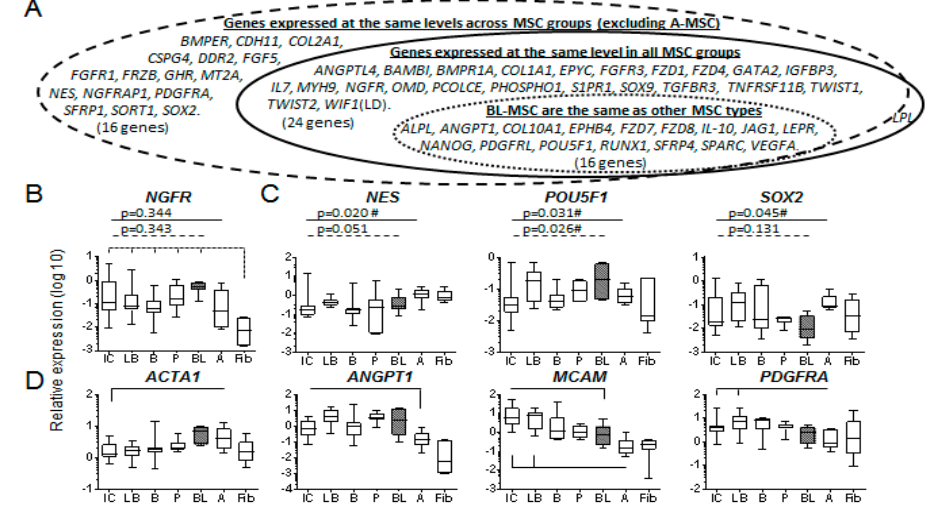
Figure 4. Evidence of molecular similarity of BL-MSCs to other MSC types. ( A ) Representation of gene expression similarity between BL-MSCs and other MSC types. Solid line: same across all MSC groups for 24 genes, dashed line: same for an additional 17 genes (but no longer LPL) when adipose-MSCs were excluded, dotted line: post-hoc multivariate analysis showed that gene expression was the same between blood-MSCs and all other MSC types for a further 14 genes. ( B ) NGFR transcript expression was the same for all MSC types, dashed lines show all MSCs (except adipose-MSCs) distinct from fibroblasts. ( C ) blood-MSCs expressed markers of immaturity at similar levels (Kruskal–Wallis) to other MSC types, no multivariate differences were found between blood and other MSC types. D ) Pericyte-related markers were expressed at similar levels across MSC types, any multivariate